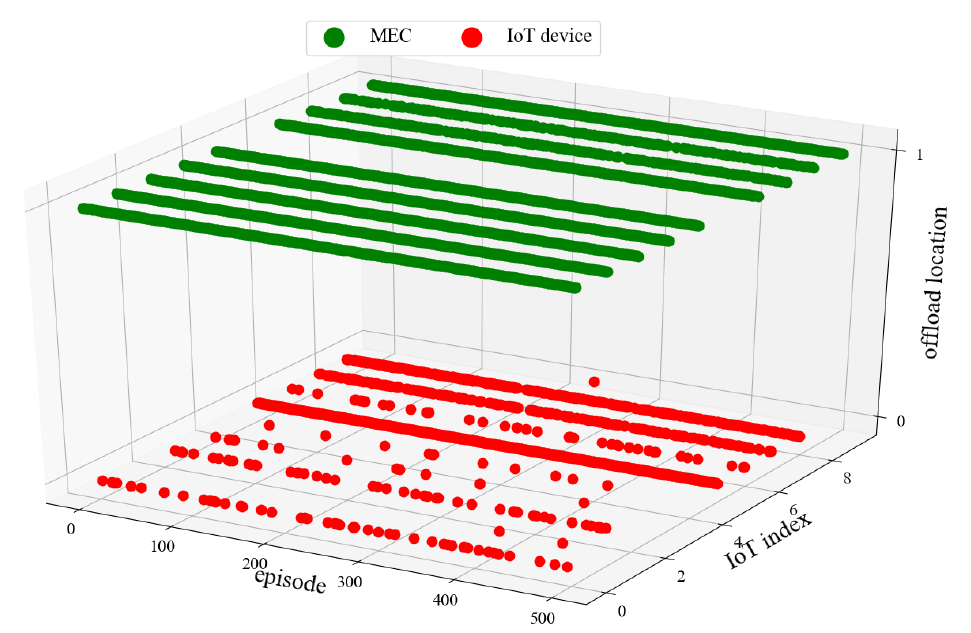
Figure 9. System bandwidth B = 5